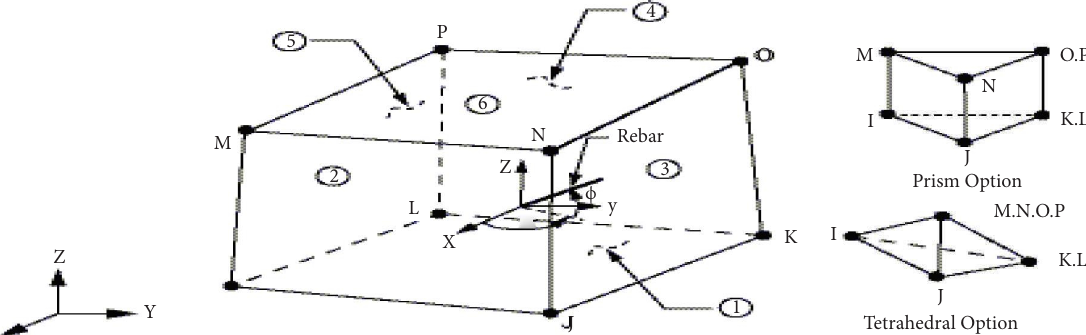
Figure 23: Geometry of element solid